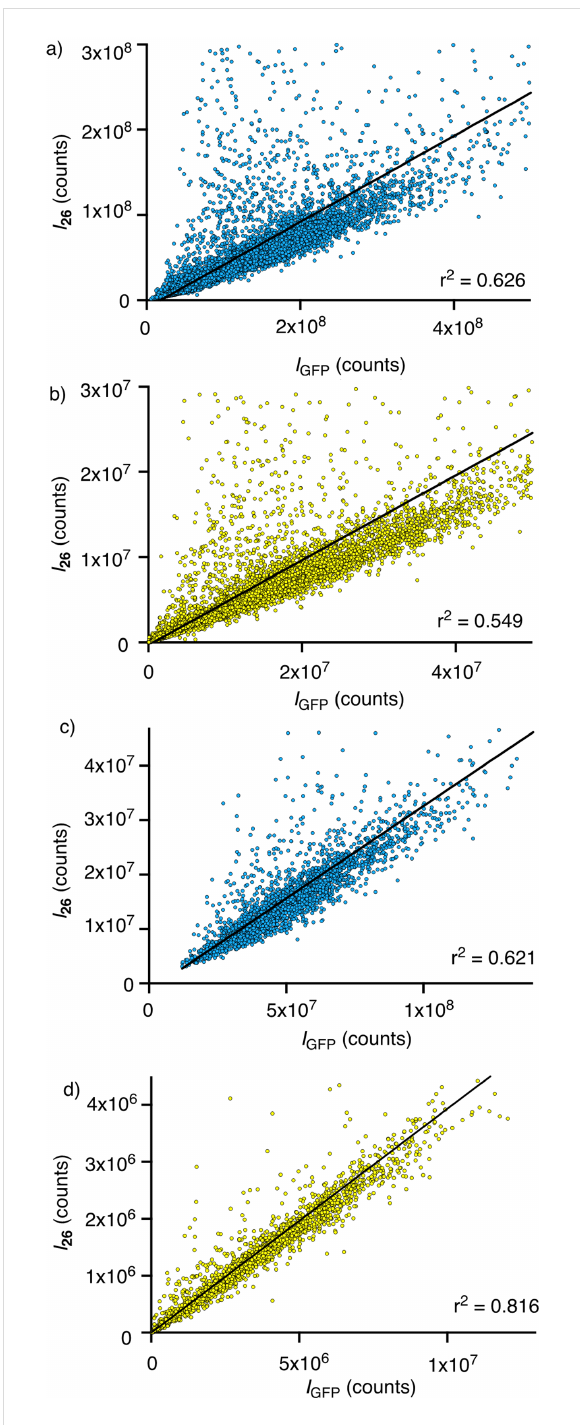
Figure 11: Evaluation of the automated HC imaging of the transiently transfected HeLa cells with HaloTag–GFP on Golgi, labeled with 26 , showing the fluorescence intensity of GFP versus 26 in a) all cells inside the cell body mask (yellow and blue areas in Figure 10a), b) all cells inside the punctate regions with a high GFP signal, considered as the Golgi apparatus (yellow areas in Figure 10a), c) selected cells inside the cell body mask (light and dark blue areas in Figure 10c), and d) punctate regions with a high GFP signal in selected cells, consid- ered as the Golgi apparatus (yellow areas in Figure